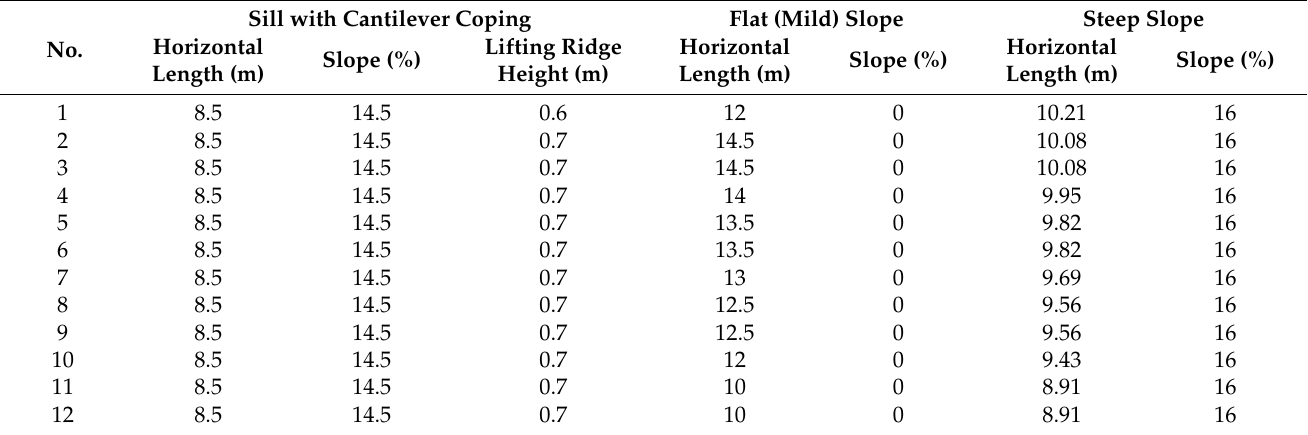
Figure 8. Optimal shape and flow pattern of aerator No. 1 (Unit: cm): ( a ) the design aerator shape of Gushui; ( b ) flow pattern. Table 3. Shape parameters of aerators No . 1–12.